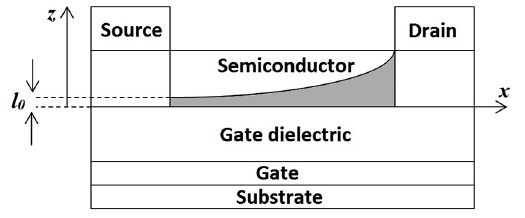
Figure 2: Schematic representation of FET showing the variation of effective channel thickness l along the x -direction, with the effective channel represented in gray.